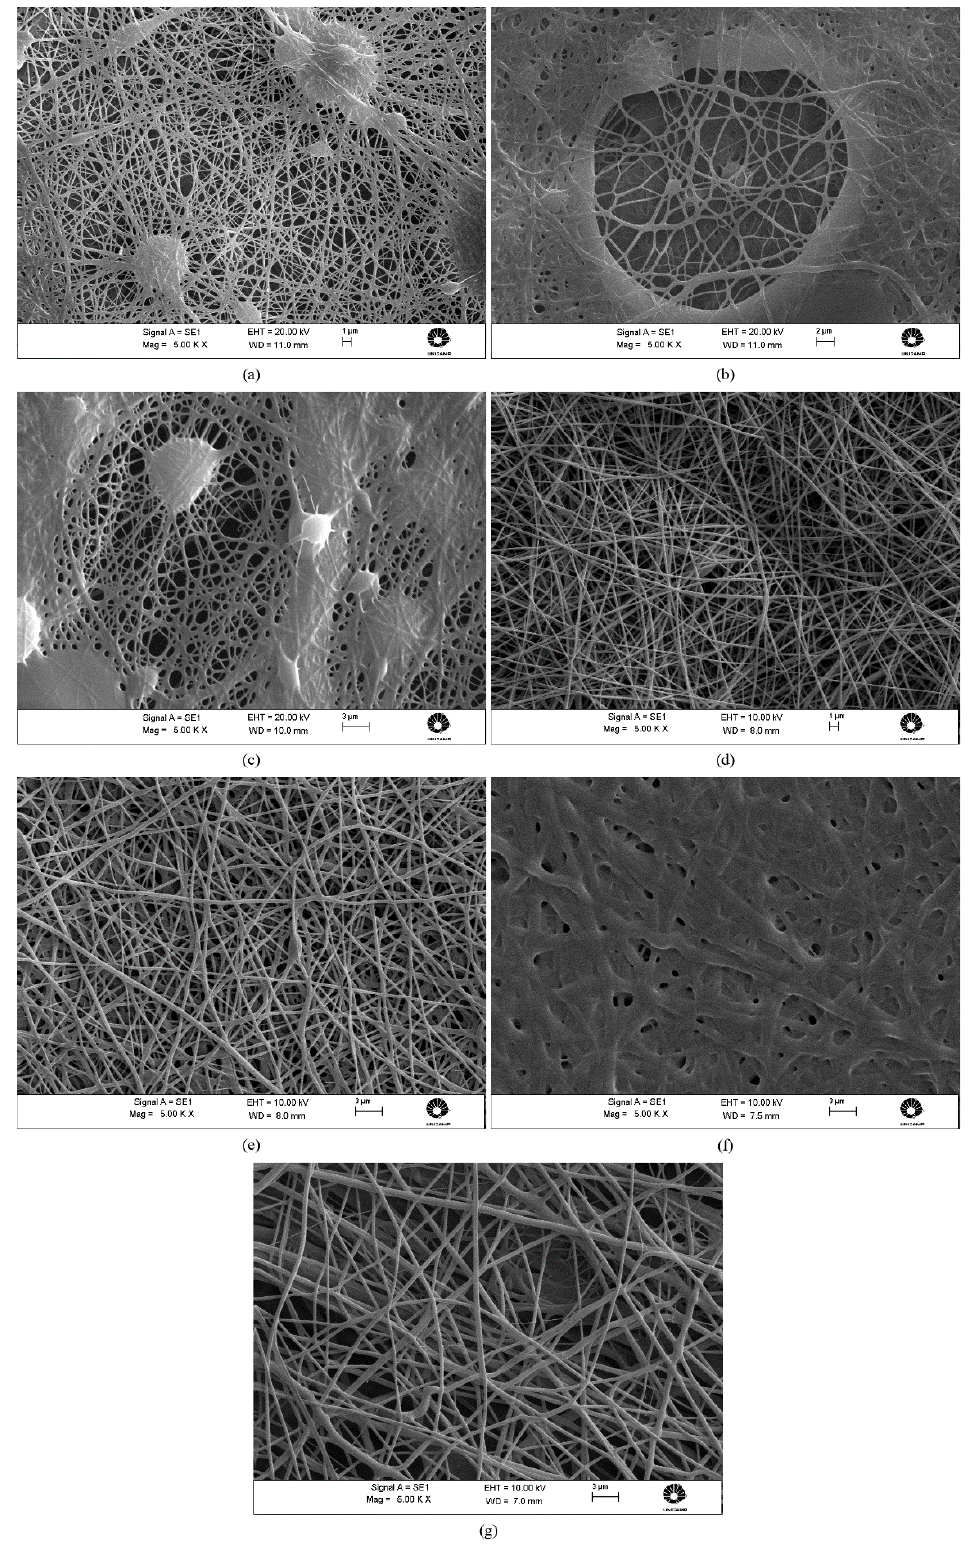
Figure 9. SEM images of the electrospun fibers from different solutions with magnification of 5000x: (a) 1 (9.3wt%), (b) 2 (18.6wt%), (c) 3 (27.8wt%), (d) 4 (37.0wt%), (e) 5 (46.3wt%), (f) 6 (55.5wt% and (g) 7